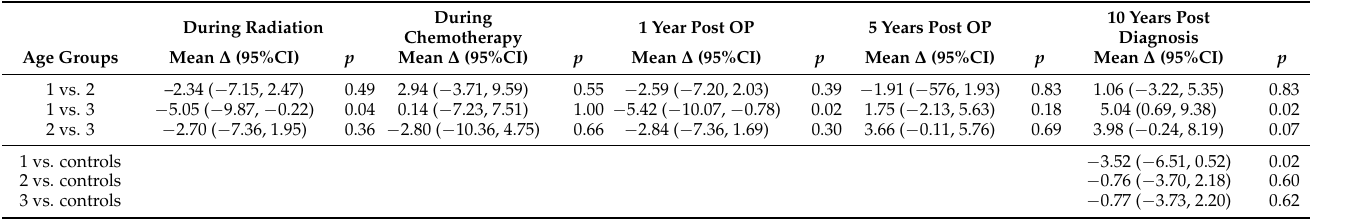
Table 2. HRQoL in breast cancer survivors during and after active treatment compared by age groups (1: ≤ 58 years, 2: 59-64 years, 3: ≥ 64 years) and compared to healthy controls of the same age group 10 years after diagnosis. During Radiation During Chemotherapy 1 Year Post OP 5 Years Post OP 10 Years Post Diagnosis